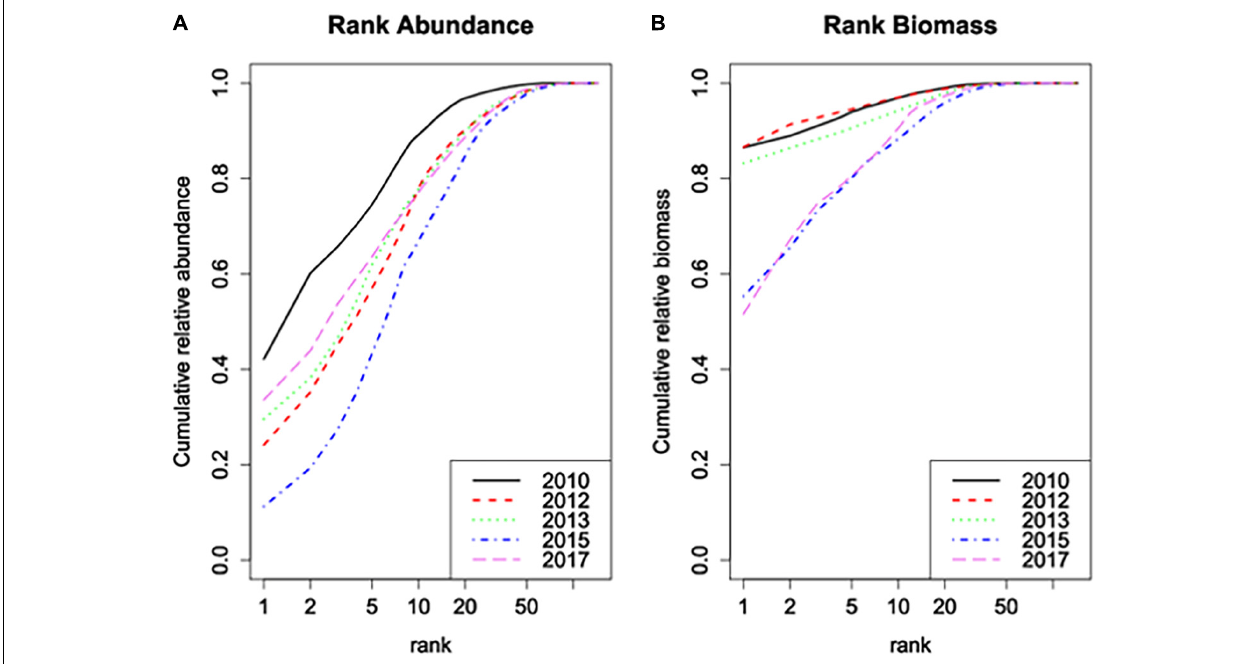
FIGURE 4 | (A) Rank abundance plot and (B) rank biomass plot of the samples of the Sand Motor area before (2010) and after construction. The plots show the cumulative fraction of the total abundance, resp. biomass that is represented by the n most dominant species, as a function of rank n.